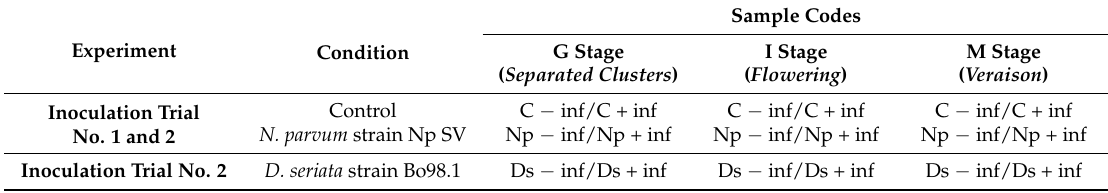
Table 1. Conditions and sample codes.